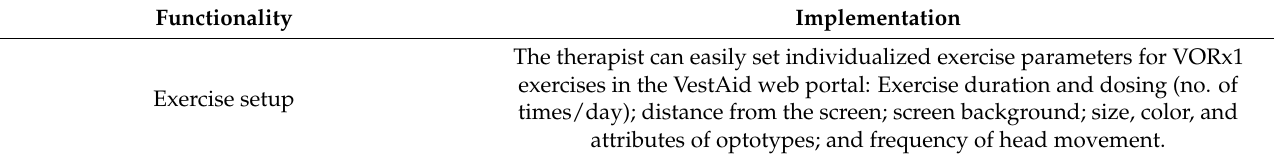
Table 1. Summary of VestAid software